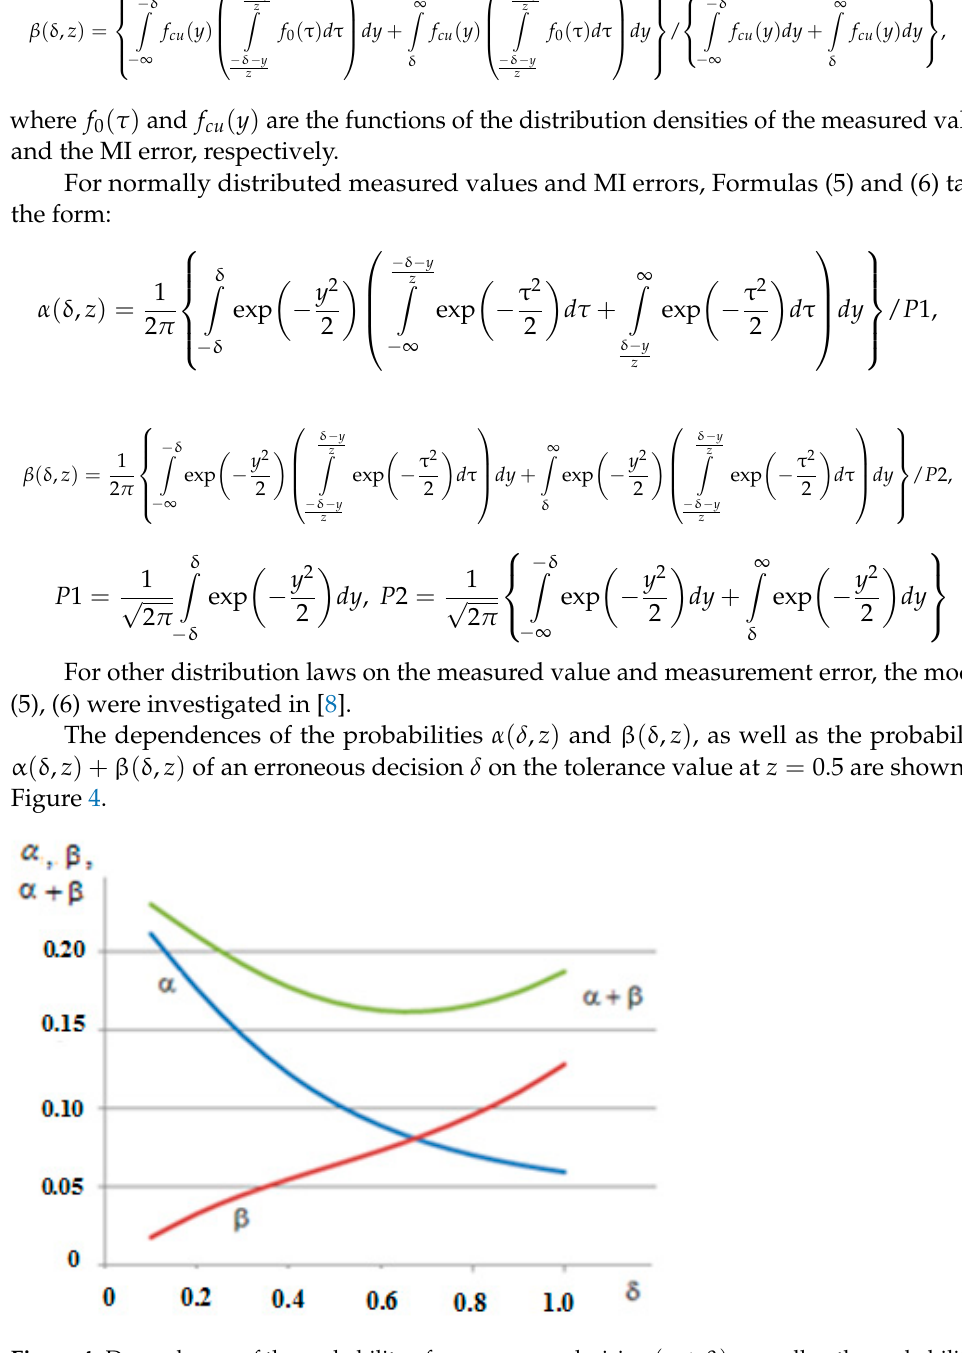
Figure 4. Dependences of the probability of an erroneous decision ( α + β ) , as well as the probabilities of false and undetected failures on the value of the reduced tolerance δ on z = 0.5. Note also that the error solution function reaches its minimum at some internal point δ ∈ ( 0; 1 ) , as is the case with the normal distribution of the measured value and the measurement error. The two-dimensional dependences of the probabilities of false and undetected fail- ures on the magnitude of the dimensionless measurement error z and the dimensionless tolerance for the controlled parameter δ are shown in Figure